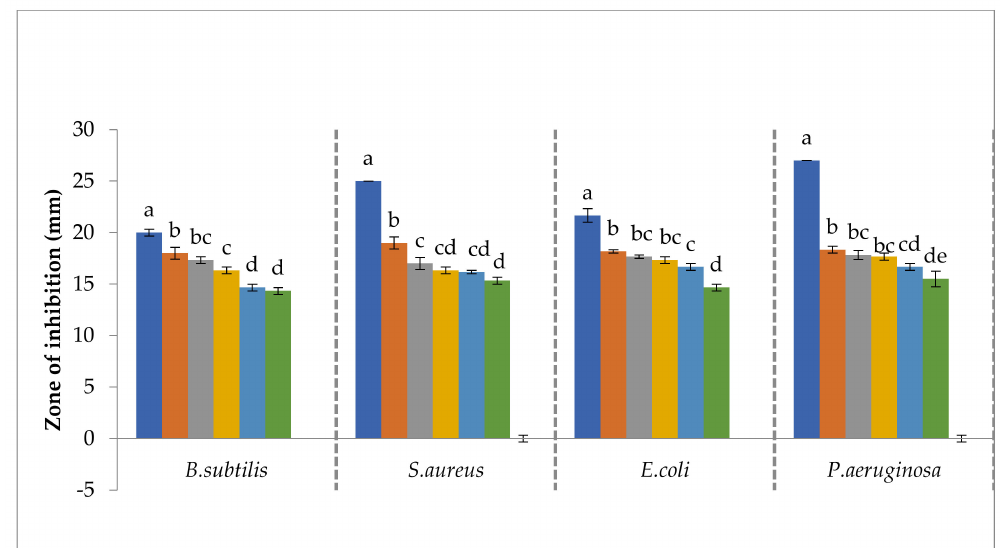
Figure 7. Antibacterial activity of methanolic:water (1:1) extracts of aerial parts of Aerva javanica against pathogenic strains Bacillus subtilis , Staphylococcus aureus , Escherichia coli , and Pseudomonas aeruginosa at different concentrations as shown in Figure 6. Different letters are indicating significant differences ( p < 0.05) among treatments.